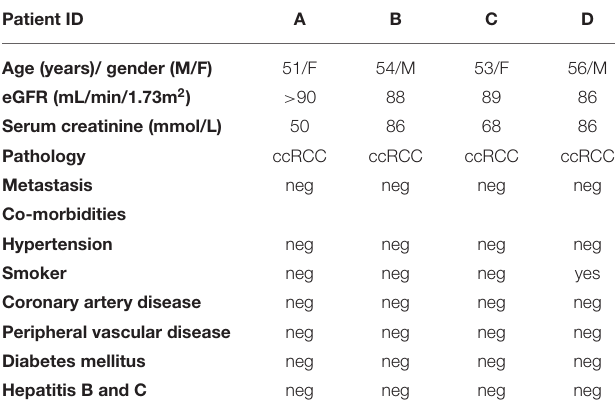
TABLE 1 | Patient cohort